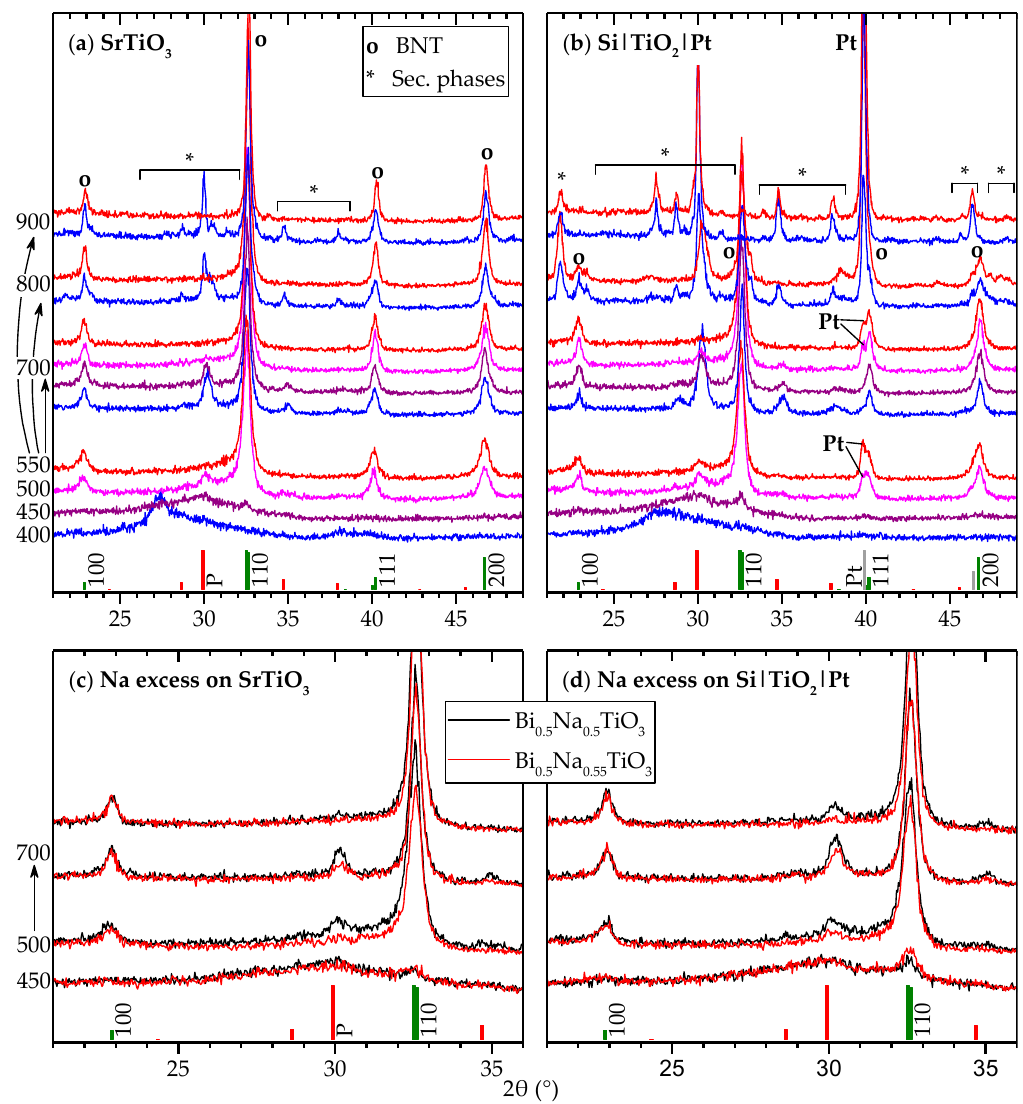
Figure 1. Grazing incidence X-ray diffraction (XRD) patterns of deposited Bi 0.5 Na 0.5 TiO 3 (BNT) films: ( a ) films deposited on SrTiO 3 (STO) substrates; ( b ) films deposited on platinized silicon (SiPt) substrates; ( c ) comparison of nominal stoichiometric (black) and 10% Na excess (red) sols on STO; and ( d ) comparison of stoichiometric and Na excess on platinized silicon. Heat treatment temperatures are denoted to the left. Arrows indicate that samples were first pyrolized for each layer, then finally annealed at the given temperature. Color codes correspond to the pyrolysis temperatures. Reference patterns are shown for R3c BNT (pseudo cubic hkl indices) [30], a Na-poor pyrochlore phase (“P”) [31] and platinum (“Pt”).